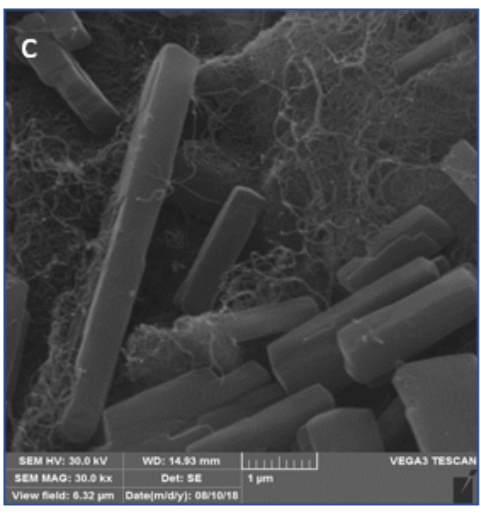
Figure 6. Images obtained by SEM: ( a ) MWCNT; ( b ) CoPc and ( c ) MWCNT-CoPc.